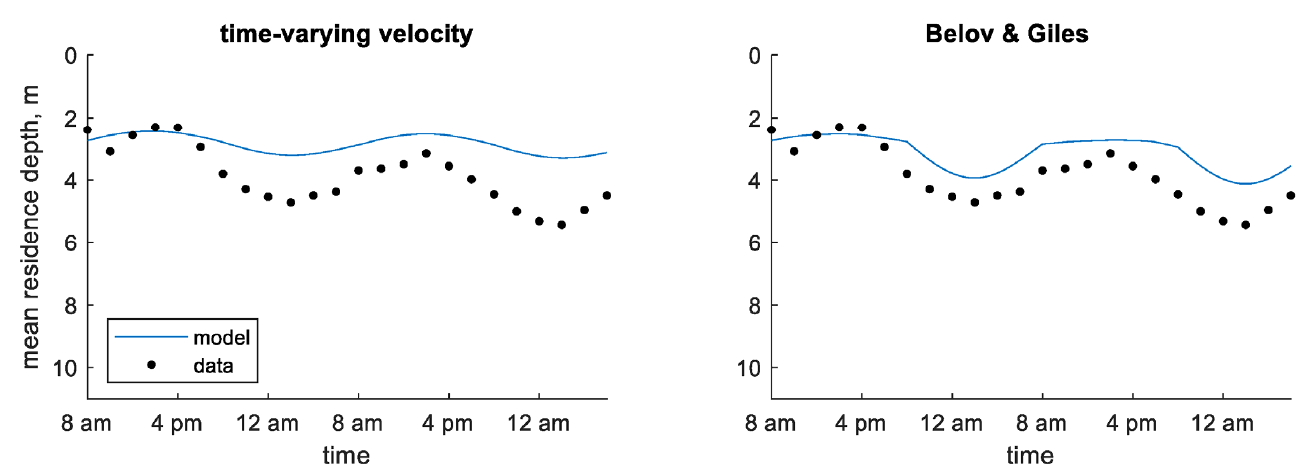
Figure 5. Time series of observed and predicted mean residence depth of chlorophyll a concentration in the Shennong Stream enclosure site using predefined velocity models (continuum)